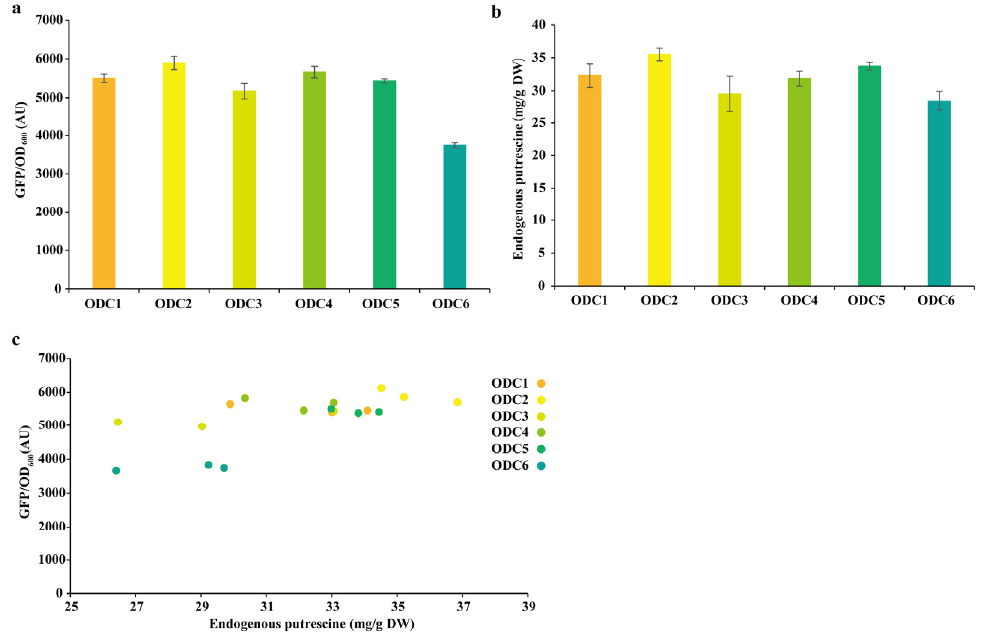
Figure 5. Putrescine biosensor for measuring intracellular putrescine concentration in recombinant strains containing ODCs. ( a ) Fluorescence ratio of the recombinant strain containing ODCs after 12 h of fermentation; ( b ) intracellular putrescine concentration of the recombinant strain containing ODCs after 12 h of fermentation. The intracellular putrescine level was normalized by CDW, which was estimated based on an optical density of 1 corresponding to 0.25 g/L CDW at a 600 nm wave- length. Values are presented as the mean ± standard deviation of three independent experiments. ( c ) Correlation between intracellular putrescine concentration and fluorescence ratio. CDW: cell dry weight; ODC: ornithine